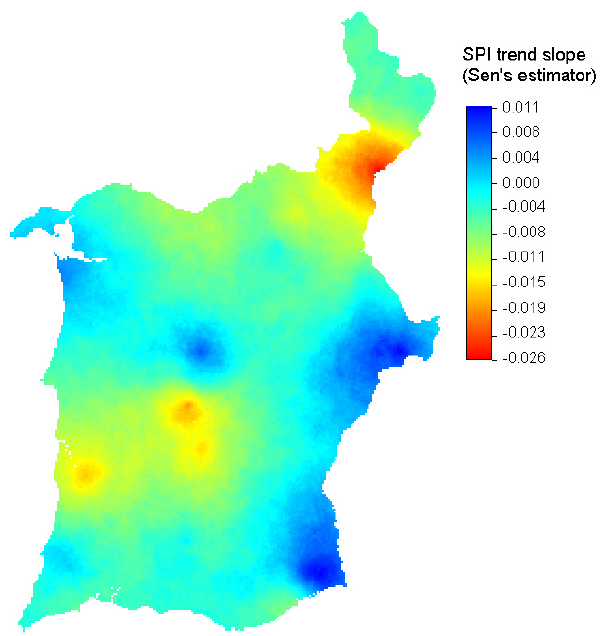
Fig.3. Local trends in the 12-month SPI. 2 Fig. 3. Local trends in the 12-month SPI.